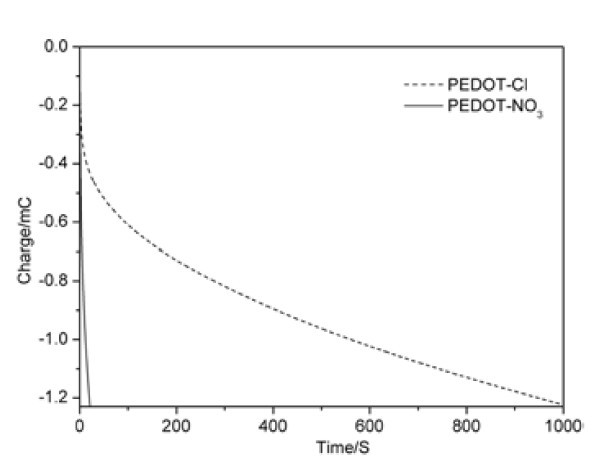
Chronocoulemetry of PEDOT deposition on Pt in 0.01 M EDOT + 0.1 M KNO3 and 0.01 M EDOT + 0.1 M KCl.